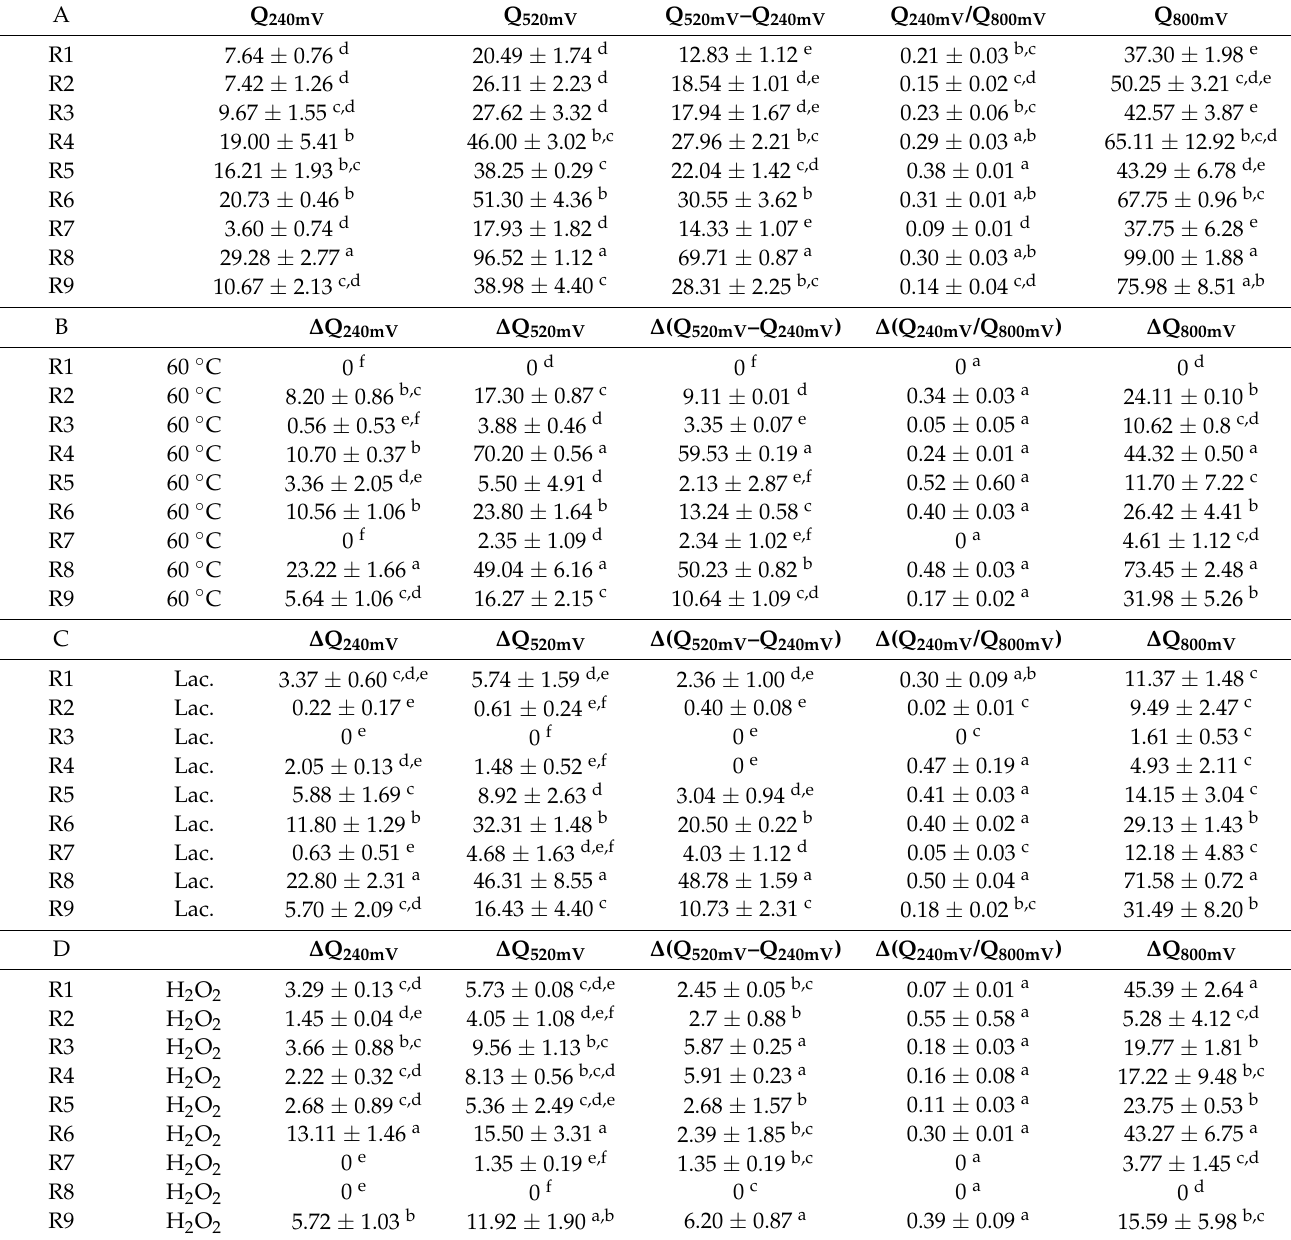
Table 4. Charges (Q) for reference (non-oxidized) wines (blanck substracted) and difference of charges ( ∆ Q) between reference wines and oxidized wines with three different accelerated protocols (60 ◦ C, laccase and H 2 O 2 ). Q and ∆ Q are expressed in µ C. Different letters indicate the significant differences between samples in one column according to Tukey’s test, p <